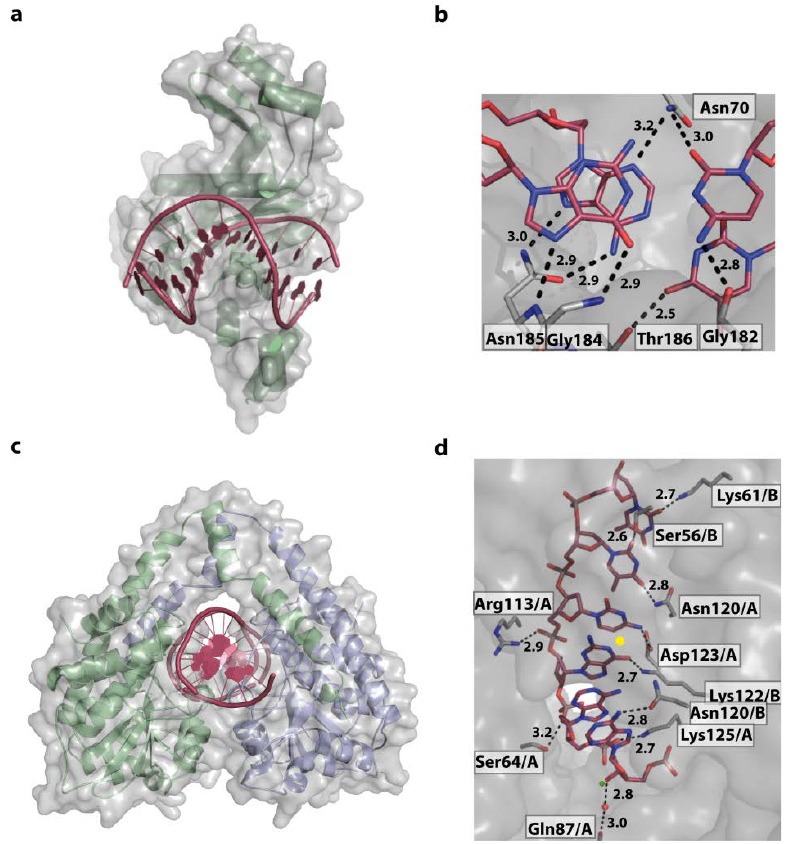
Figure 8. The restriction endonucleases Eco RV and Hin dIII. ( a ) Overall structure of the Eco RV DNA-complex (PDB code 1RVB). For clarity only one of two symmetrically binding protein molecules is shown. The DNA is kinked by 50°; ( b ) Eco RV interacts intensively with the outer GC and AT bases forming 8 direct contacts with almost all functional groups; ( c ) Structure of Hin dIII/DNA (PDB code 3A4K) complex displaying the symmetrical bound dimer embedding the DNA; ( d ) Active site of Hin dIII with, for clarity, one of the palindromic target sequence AAGCTT. Direct and water mediated contacts are formed. Water molecules, and for catalysis, required Mg 2+ ions are shown as red and green spheres, respectively. The symmetry axis of the complex is located in middle of target sequence, between bases GC/CG and indicated as a yellow